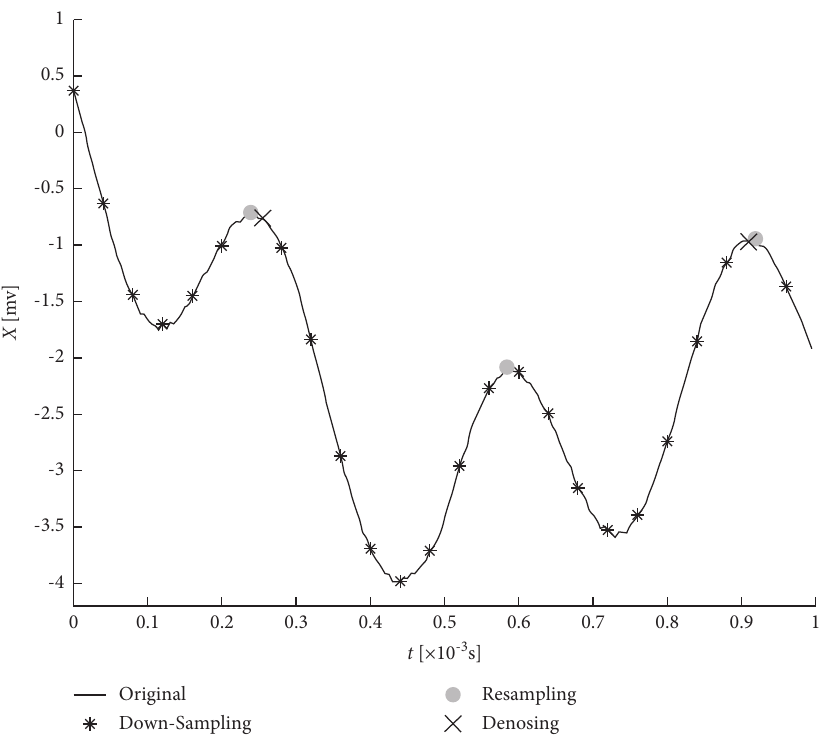
Figure 6: The physical meaning of the DSLR phase demodulation